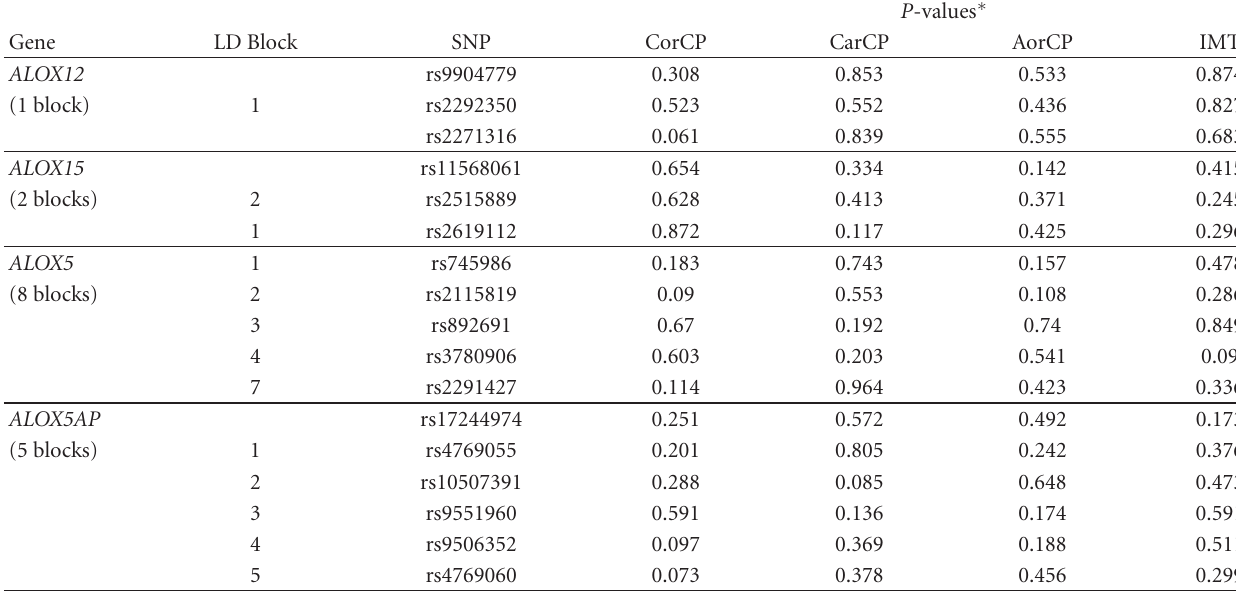
Table 3: Significance of association tests of ALOX12 , ALOX15 , ALOX5 , and ALOX5AP SNPs with measures of atherosclerosis, independent of epidemiologic risk